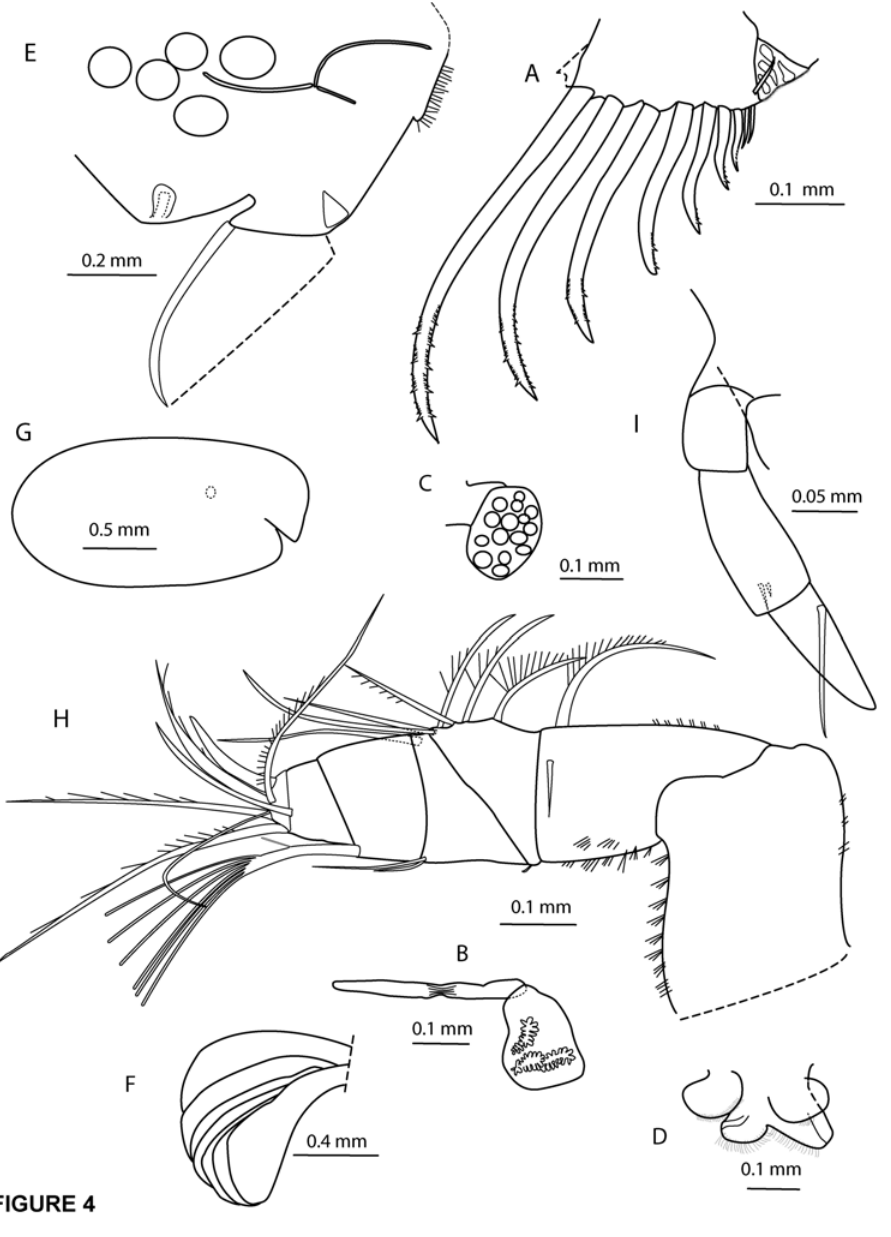
Figure 4. Cylindroleberismariae , adult female, specimen number NMSZ 1996.004.293. A, furca, left lamella, l.v.; B, medial eye and Bellonci organ; C, lateral eye; D, upper and lower lips, dorsal view; E, posterior of body, left, l.v., reproductive organ dotted, eggs (or parasites) shown as circles; F, gills, right lamella, l.v. Cylindroleberis mariae , A-1 male NMSZ:1996.004.427; G, carapace outline, right, l.v., position of lateral eye dotted; H, first antenna, left, l.v.; I, second antenna endopod, left, m.v.